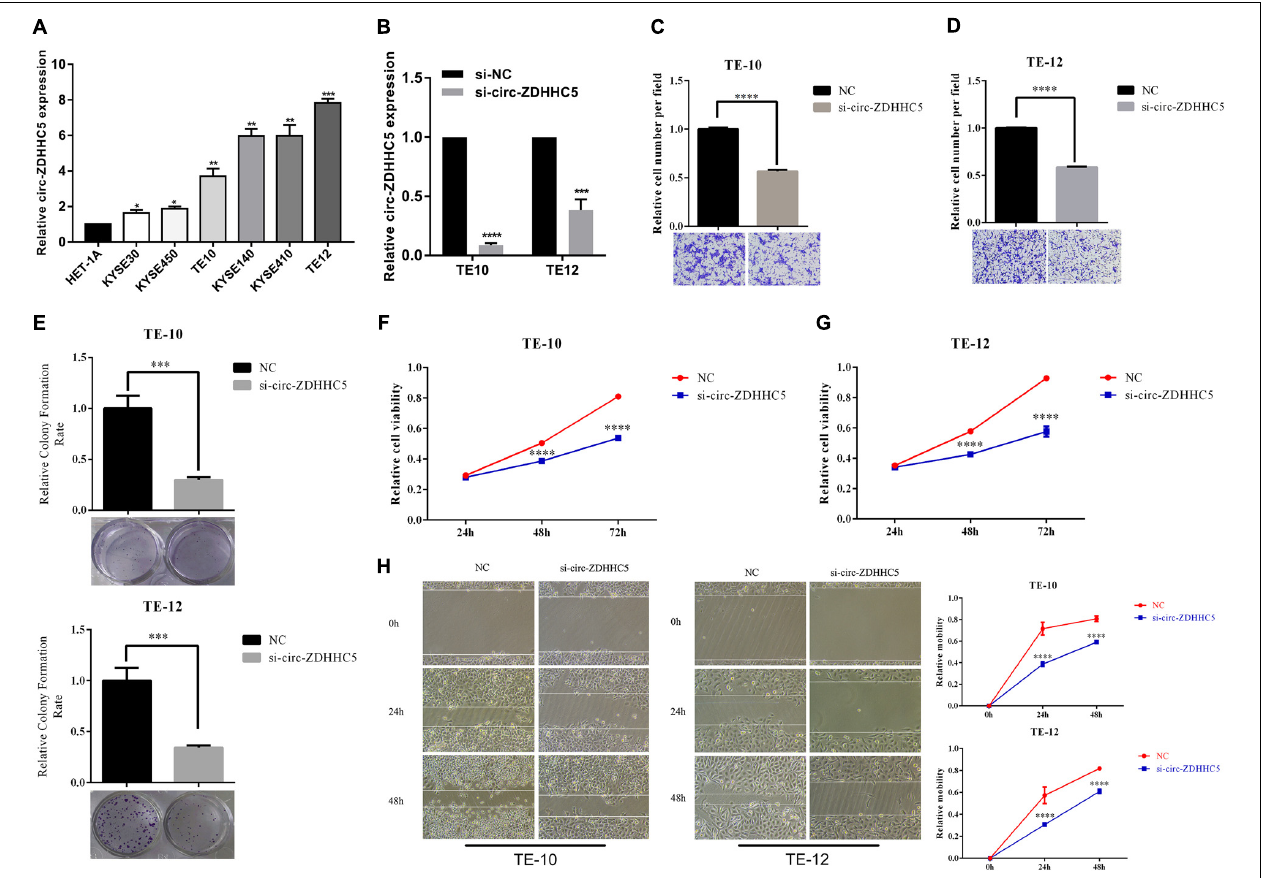
FIGURE 2 | Circ-ZDHHC5 produces oncogene effects on ESCC cells. (A) The expression of circ-ZDHHC5 was assessed in cell lines with qRT-PCR. (B) circ-ZDHHC5 were knocked down effectively in ESCC cells. (C,D) Cell invasion experiments were conducted in cells transfected with control or si-circ-ZDHHC5. (E) Colony formation experiment showed the population dependence of si-circ-ZDHHC5. (F,G) The growth curves of cells were ascertained after transfection with si-circ-ZDHHC5 or si-NC with CCK-8 experiments. (H) Cell motility was determined in cells transfected with si-circ-ZDHHC5 or si-NC by the wound healing experiment. (* p < 0.05, ** p < 0.01, *** p < 0.001, **** p <